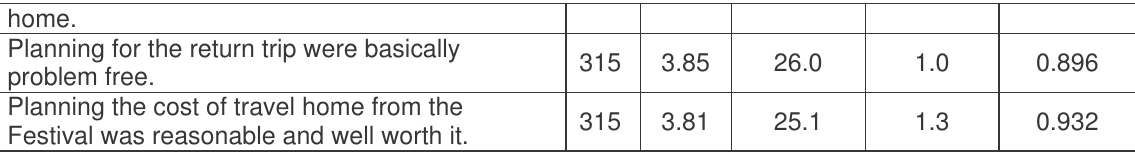
Table 4: Satisfaction with travel/tourism experiences Satisfaction with travel/tourism experiences Activity N Mean